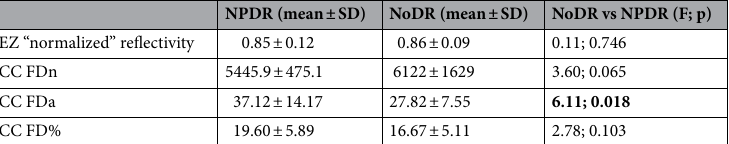
Table 2. Descriptive (mean ± SD) and inferential statistics (F;p) for OCT/OCTA values in diabetic patients without diabetic retinopathy (NoDR) and mild signs of diabetic retinopathy (NPDR). EZ = ellipsoid zone, CC = choriocapillaris, FDn = flow deficit number, FDa = flow deficit average area, FD% = flow deficit percentage. The bold type highlights the statistically significant p-values (p<